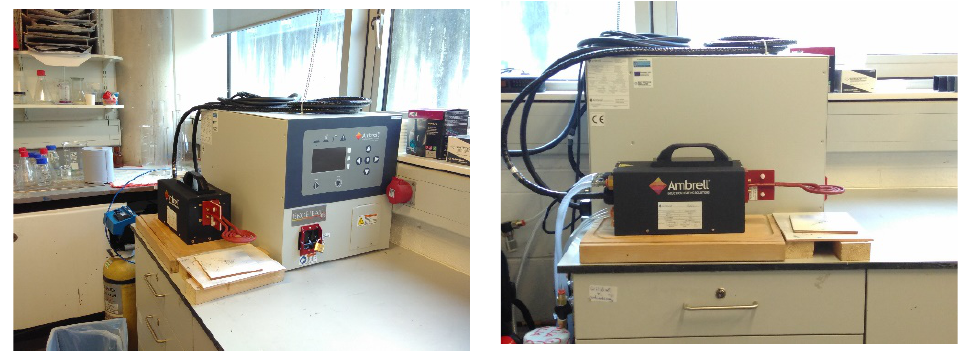
Figure 6. Ambrell Ekoheat 10 kW Induction Machine.